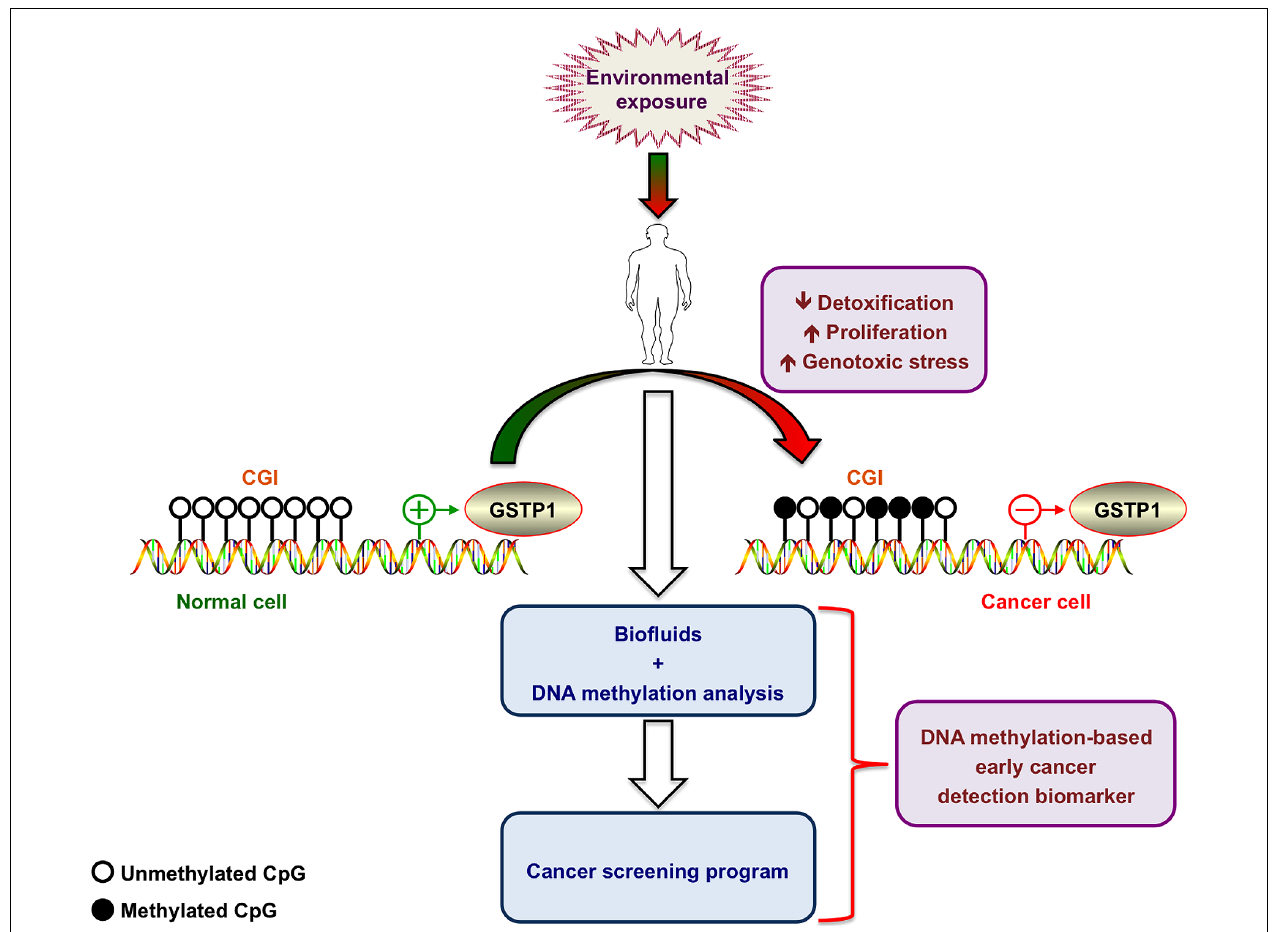
genetic alterations accompanied by an increased proliferation rate. DNA methylation analysis of the GSTP1 promoter in body fluids allows detecting progressive hypermethylation and turns this molecular feature into a valid early cancer biomarker. Figure was generated by using